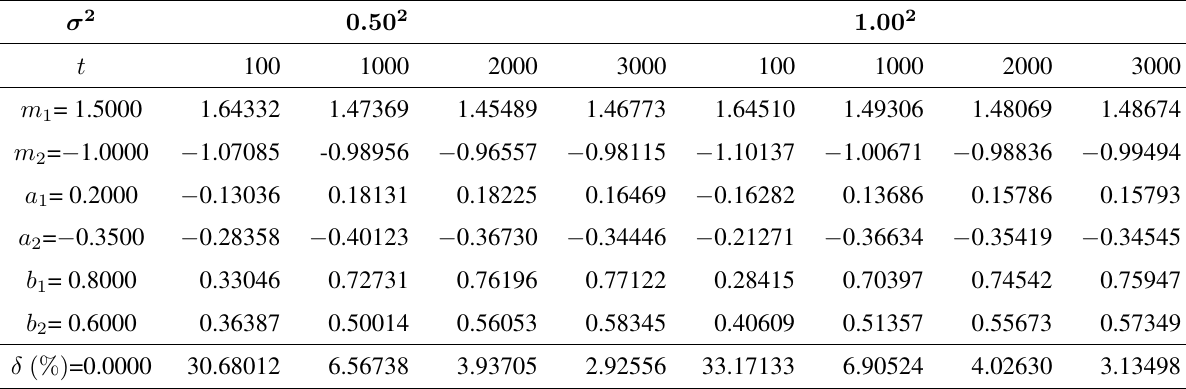
Table 2. The single-rate parameter estimates and